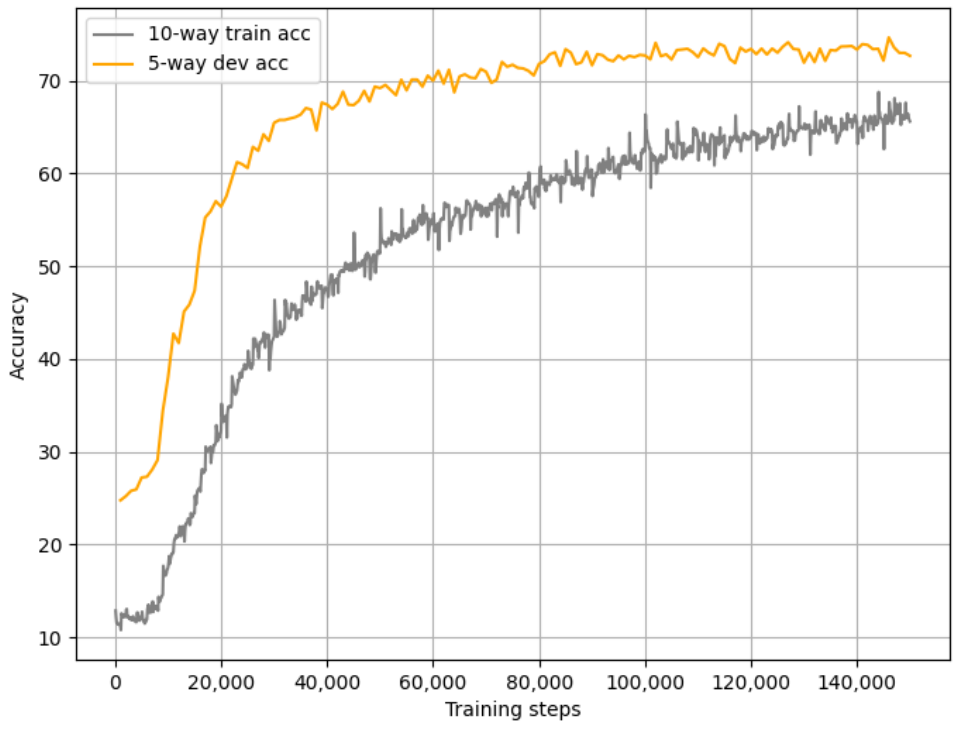
Figure 4. Comparison of training steps for training and development set performance for